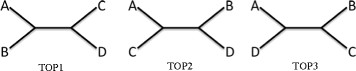
Quartet topologies. The three possible quartet topologies for four taxa A, B, C and D.